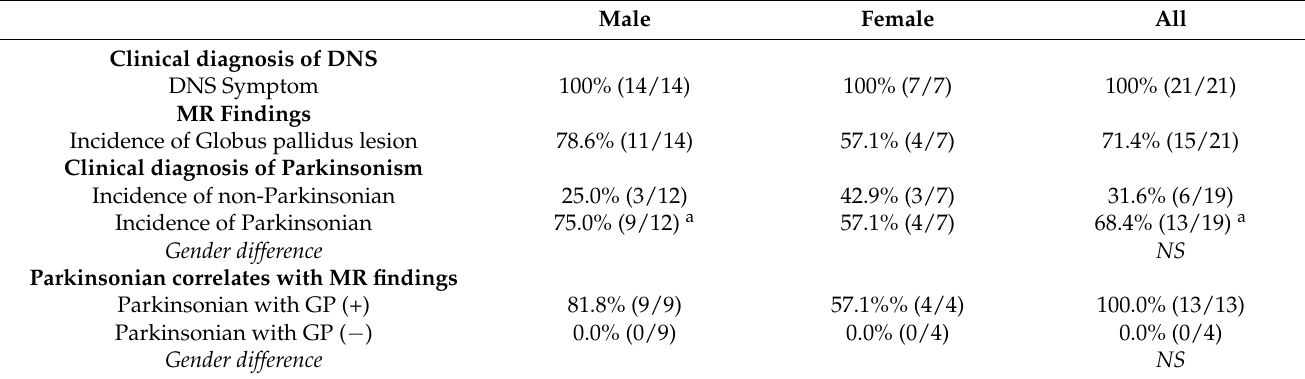
Table 2. Association of MR imaging features in the globus pallidus (GP) with diagnosis of Parkinsonism. Male Female